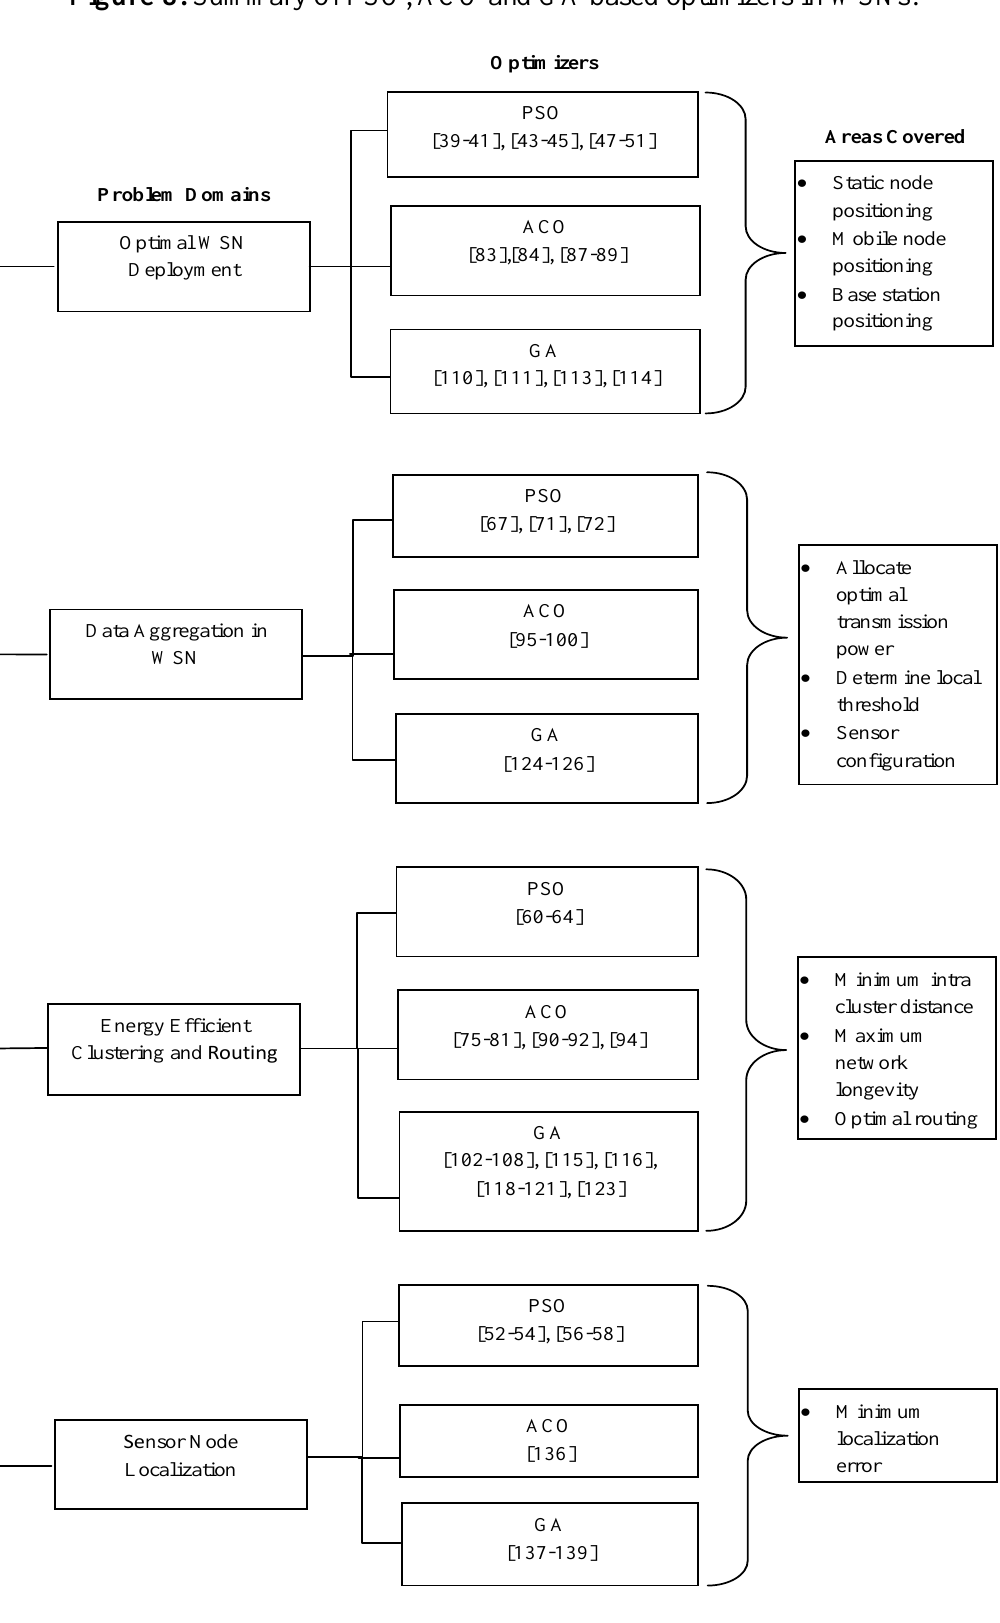
Figure 8. Summary of PSO, ACO and GA based optimizers in